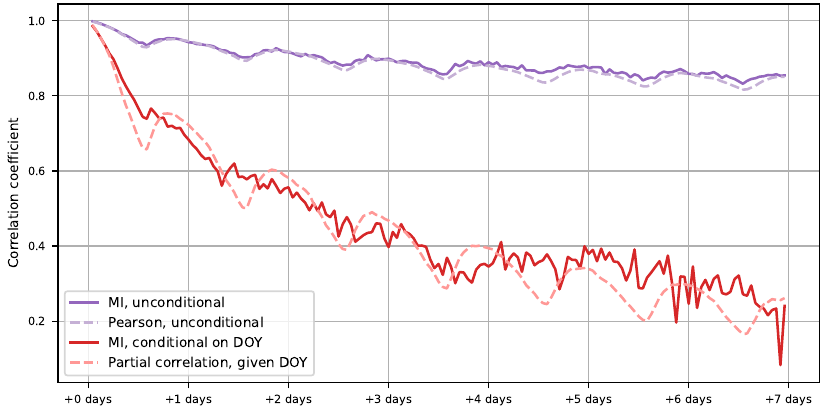
Figure 6. MI (solid lines) and Pearson correlation (dashed lines) between temperature measured at 15:00 and hourly temperature measurements up to 7 days after this. The top two lines are results without deseasonalization and the bottom two take seasonality into